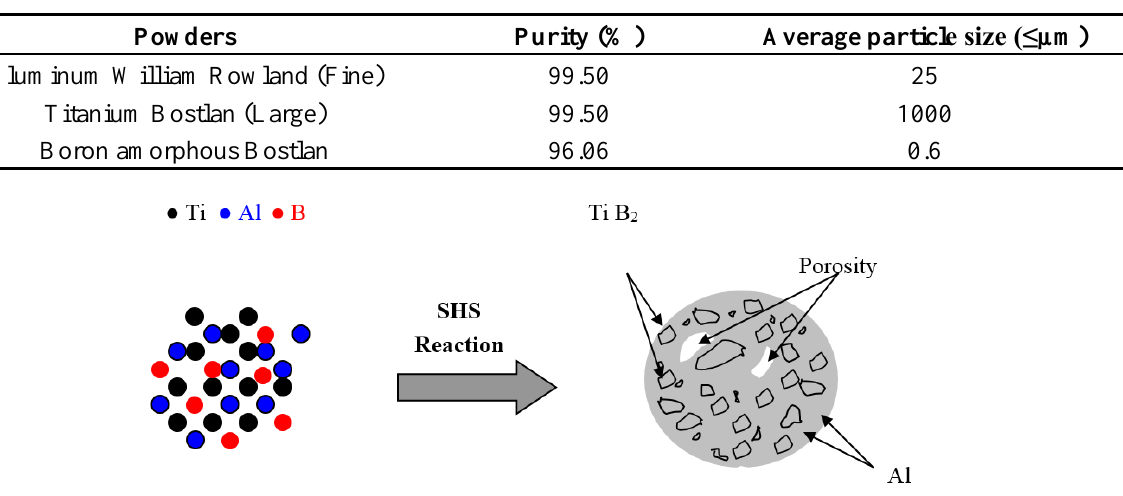
Figure 1. Schematic self-propagating high-temperature synthesis (SHS) Reaction with initial reactive powders and obtained phase